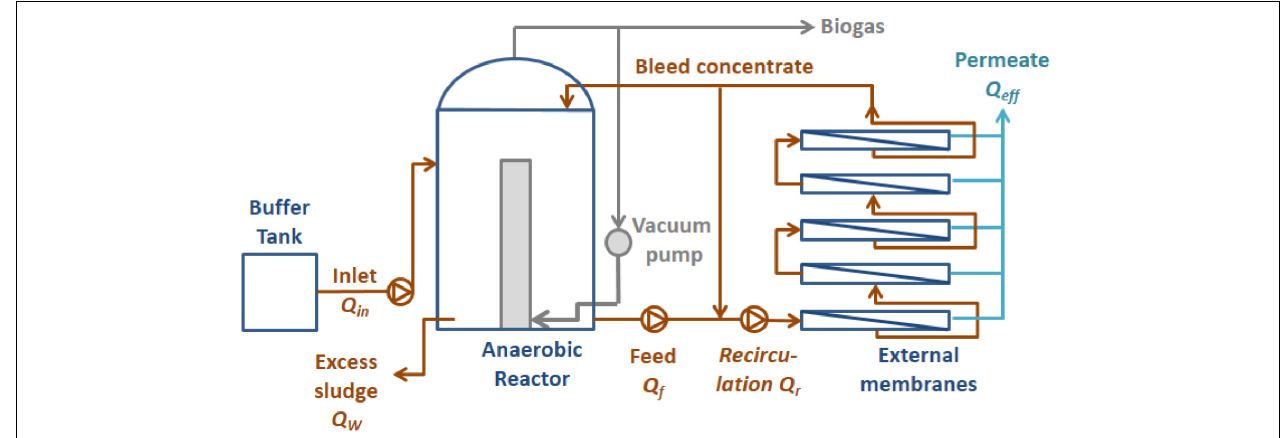
FIGURE 1 | Diagram of the AnMBR reactor and the external ultrafiltration membranes.